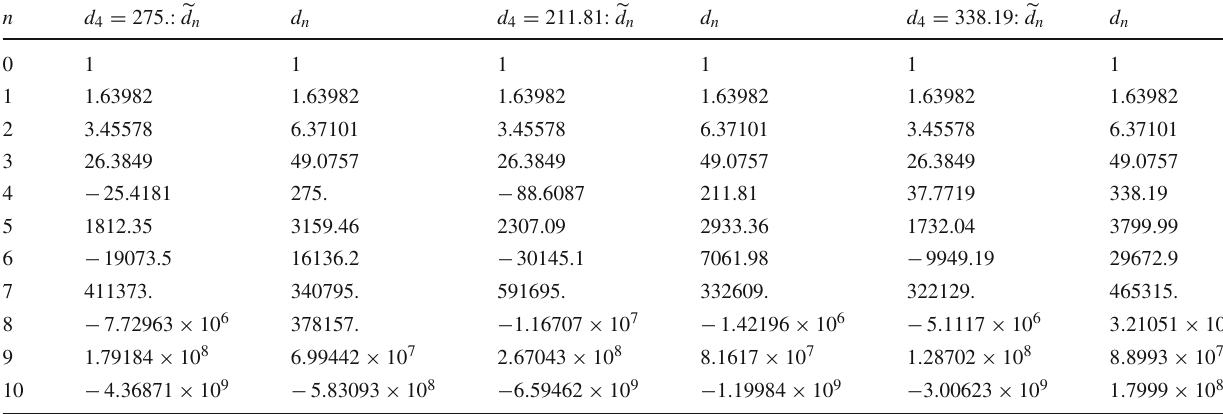
(X=IR, UV) for the five-parameter ansatz (22) in the MS scheme, when d 4 is taken i , j